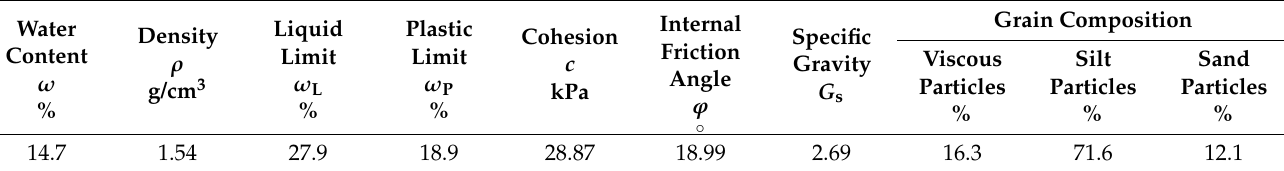
Table 1. Physical and mechanical properties of loess in the study